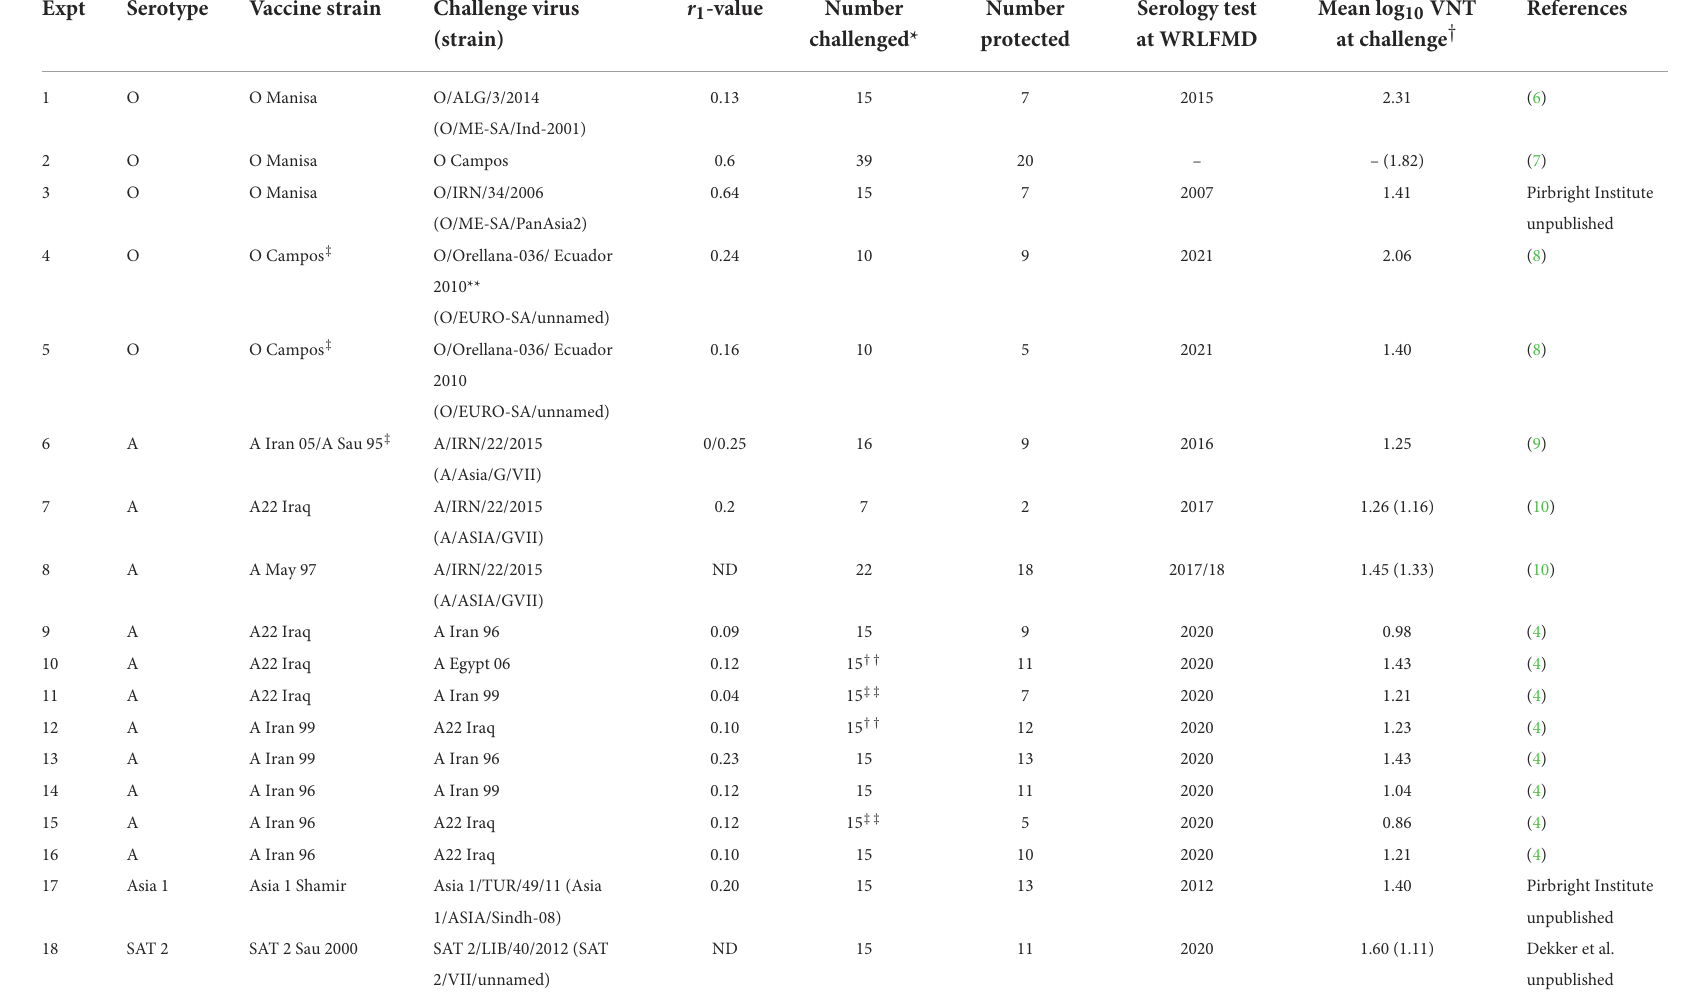
TABLE 1 Summary of heterologous vaccination-challenge studies for foot-and-mouth disease included in the